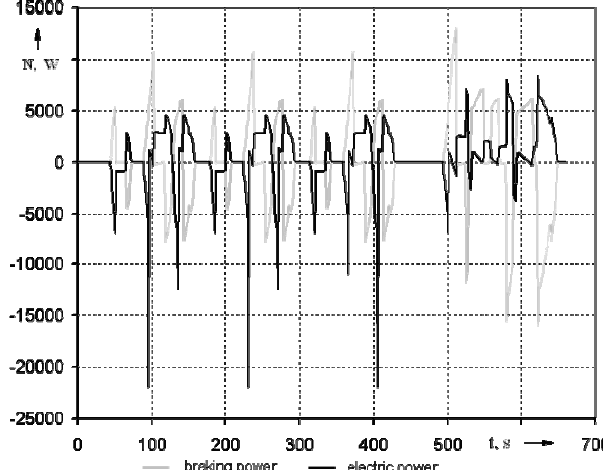
Fig 16. Power characteristics of series hybrid drive, Japanese driving cycle